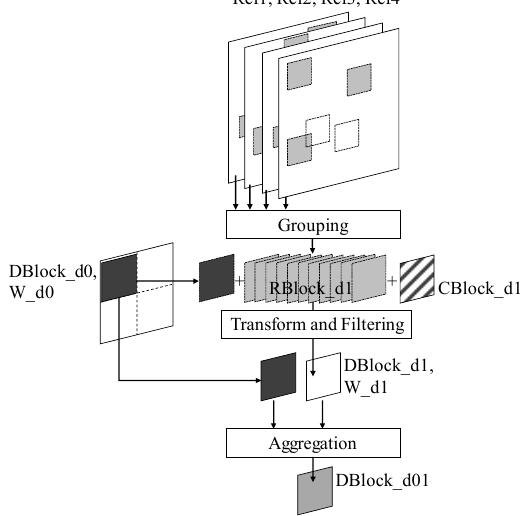
Figure 3. Overlapping patch acquisition and aggregation.